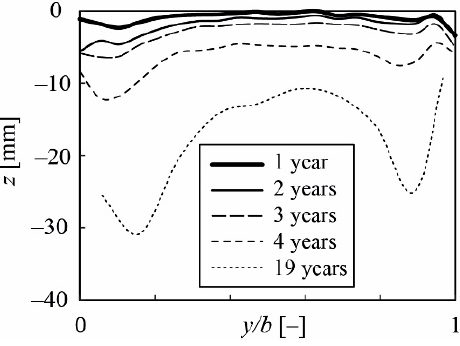
Figure 12. Super-elevated, longitudinally averaged cross-sectional abrasion profiles of the silica fume concrete test field (SC) in Runcahez SBT.